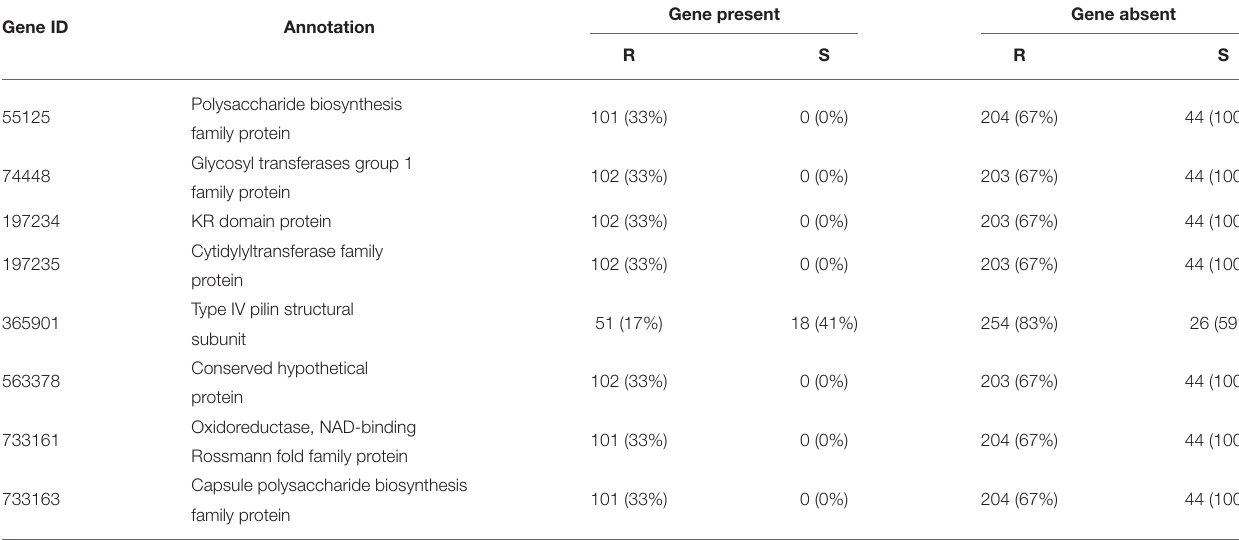
TABLE 3 | Prevalence within our collection of isolates of genes found by Wallace et al. (2016) to be associated with imipenem-resistance in A. baumannii . Gene ID